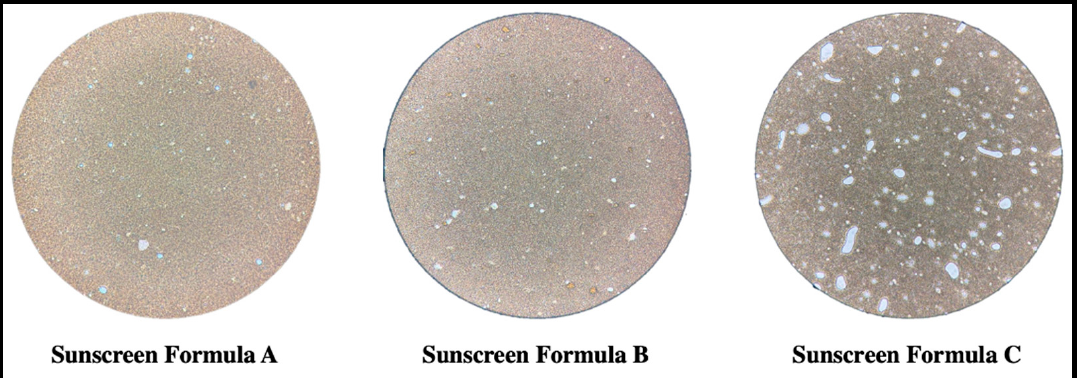
Figure 1. The coating based on Sodium Lauroy L Glutamate, Lysine that covers this type of commercial ZnO (Formula B) is able to optimize the wettability and dispersion of the powder in the chosen oily phase, as compared to uncoated ZnO (Formula A) or Zinc Oxide, Stearic Acid (Formula C).